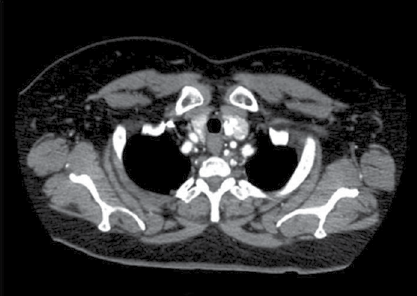
Figure 2: CT chest w/contrast demonstrating multinodular goiter.